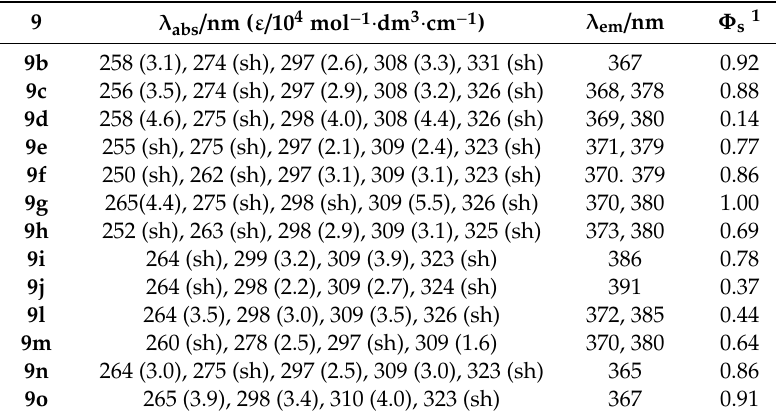
Figure 4. Normalized emission spectra of 9 (10 − 6 M) in cyclohexane. Table 5. Absorption and emission data for 9 and 10